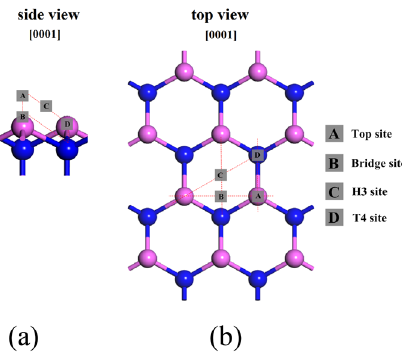
Figure 2. ( a ) Side-view and ( b ) Top-view of (2 × 2) slab model of the AlN (0001) surface. The signs show the adsorption sites for III-group and V-group sources, where pink and blue spheres denote aluminum and nitrogen atoms,